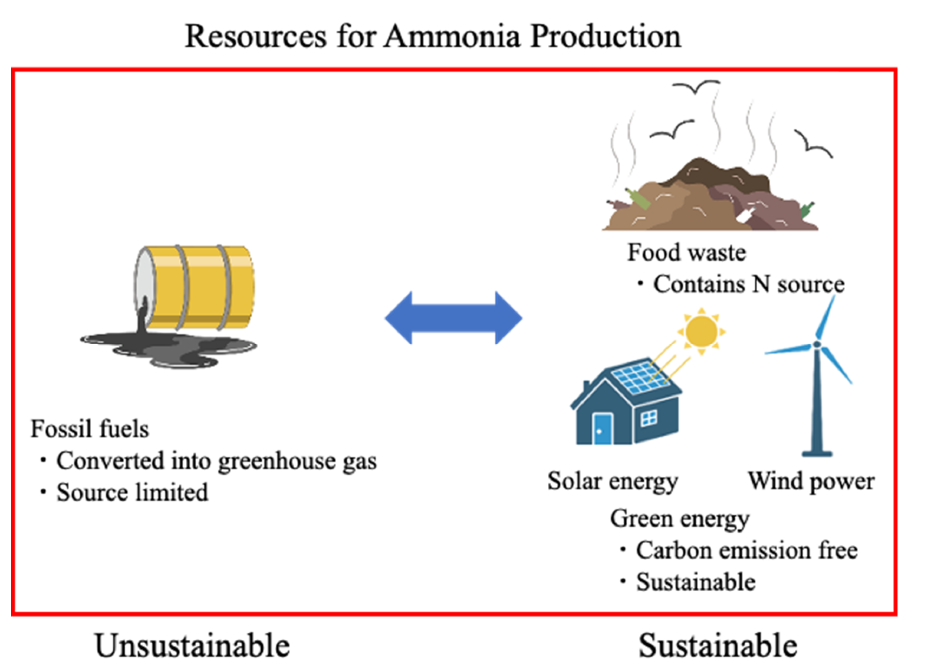
Figure 1. Sustainable resources of energy for a sustainable society (created with Biorender.com).